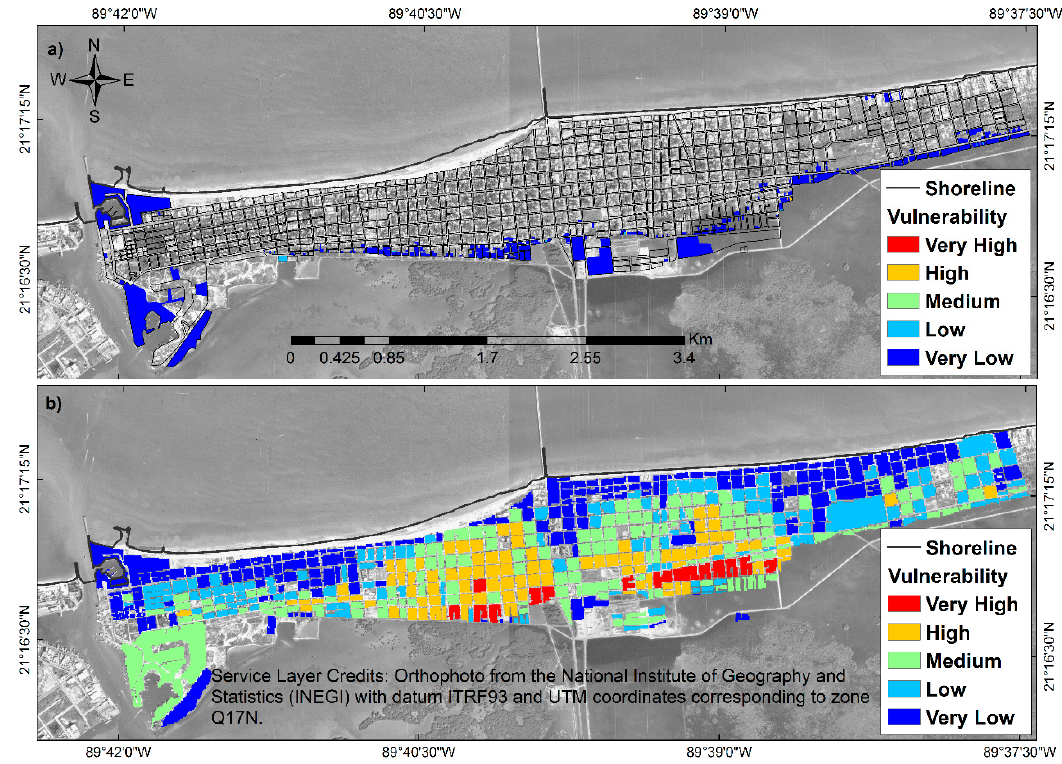
Figure 4. Flood vulnerability maps. ( a ) CENAPRED vulnerability and ( b ) socioeconomic vulnerability for Progreso, Yucatan. The categories in ( a , b ) are similar and correspond to the values defined for vulnerability in Table 2.